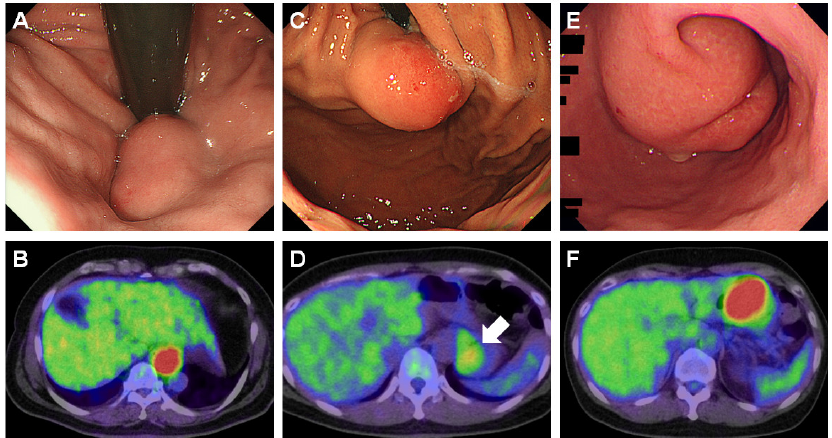
Figure 1. Representative endoscopic and 18F-fluorodeoxyglucose (FDG)-positron emission tomography images of gastric gastrointestinal stromal tumor (GIST), leiomyoma, and schwannoma. High-grade GIST that presented as a subepithelial tumor in the gastric cardia ( A ) and showed increased FDG uptake ( B , maximum standardized uptake value [SUVmax] = 11.4, tumor size: 4.6 cm). A gastric leiomyoma was observed as a subepithelial lesion in the cardia ( C ). The SUVmax of the leiomyoma was 2.75 ( D , tumor size: 2.1 cm). A schwannoma in the gastric body ( E ) showed increased tracer accumulation ( F , SUVmax = 9.01, tumor size: 5.5 cm).